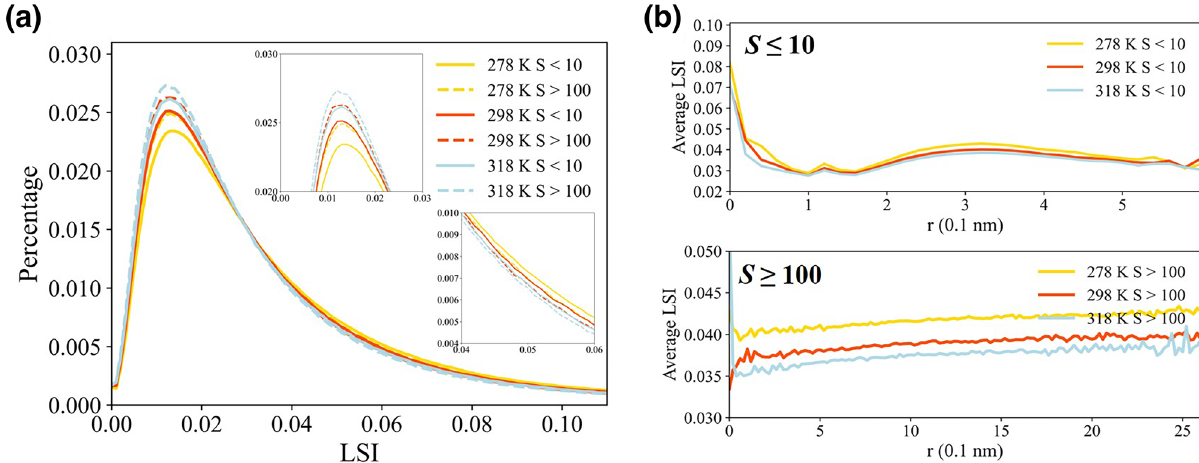
Figure 7. The distribution of LSI for waters in the vicinity of the clusters at various temperatures. ( a ) The distribution of the LSI of water molecules in the clusters at 278 K, 298 K and 318 K. The solid line denotes the clusters with S ≤ 10, and the dashed line denotes the clusters with S ≥ 100. ( b ) The average LSI around the geometrical center of clusters with S ≤ 10 and S ≥